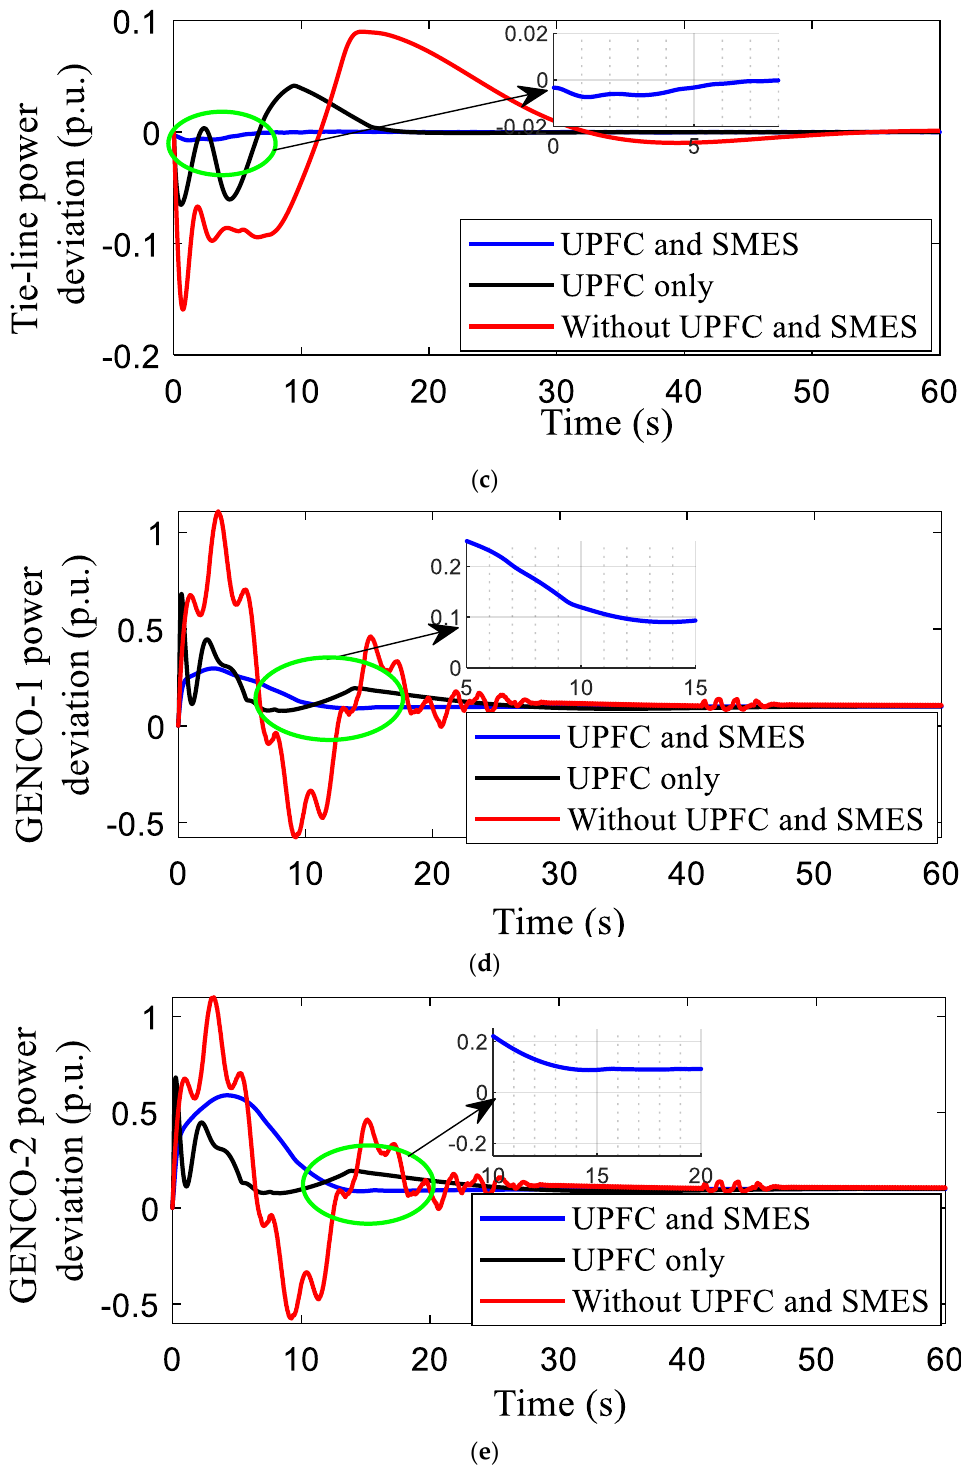
Figure 11. Dynamic performance of Test-1: ( a ) frequency deviation in area-1; ( b ) frequency deviation in area-2; ( c ) tie-line power deviation; ( d ) GENCO-1 power deviation; ( e ) GENCO-2 power deviation. In order to calculate the desired power generation of each GENCO, Equation (9) can be adjusted as